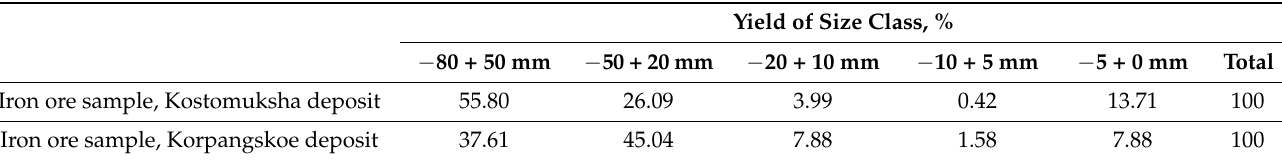
Table 3. Granulometric composition of studied iron ore samples.